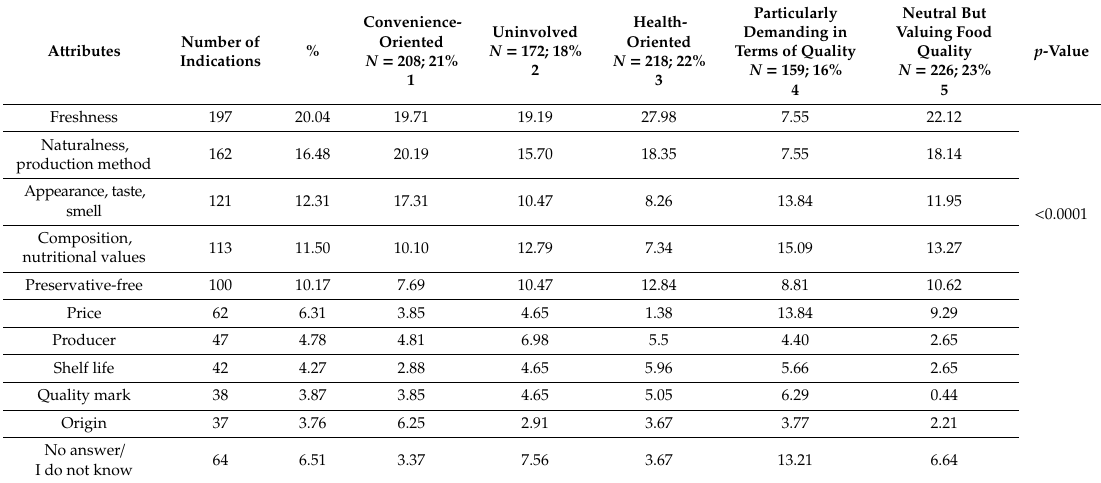
Table 3. Attributes describing food quality in consumer reviews